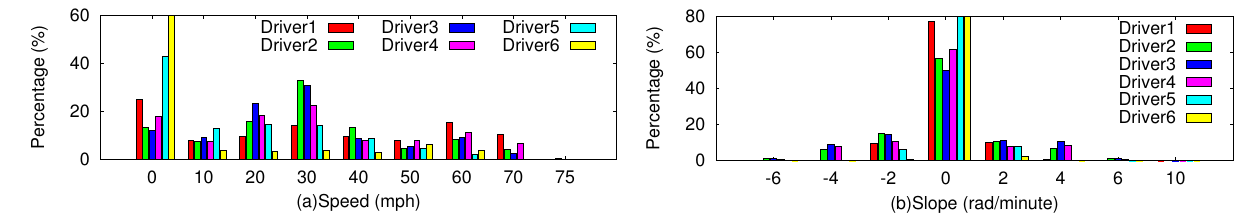
Figure 13. Speed and slope histogram comparison of different